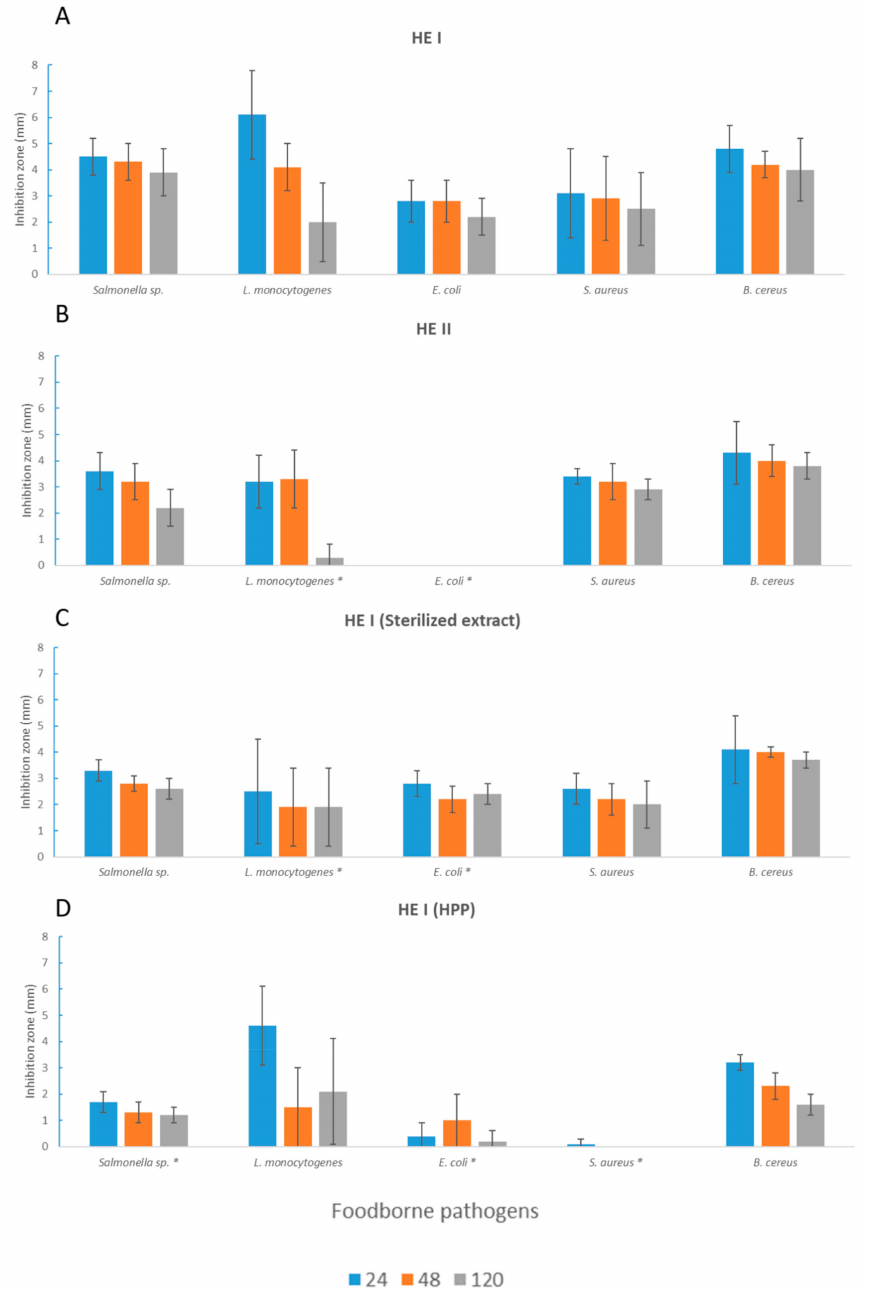
Figure 2. Inhibition radius (mm) of extracts obtained from unfermented seaweed in terms of foodborne pathogens ( A : HE I, B : HE II, C : sterilized extract obtained from HE I, D : HE I treated with HPP). Measurements were taken after 24, 48, and 120 h. Values ± standard deviations are reported. Here, * expresses the significance ( p < 0.05) of the antimicrobial activity of HE I and of the other extracts ( HE II, HE I (sterilized extract), and HE I (high-pressure-processed (HPP))) for each time point (24, 48, and 120